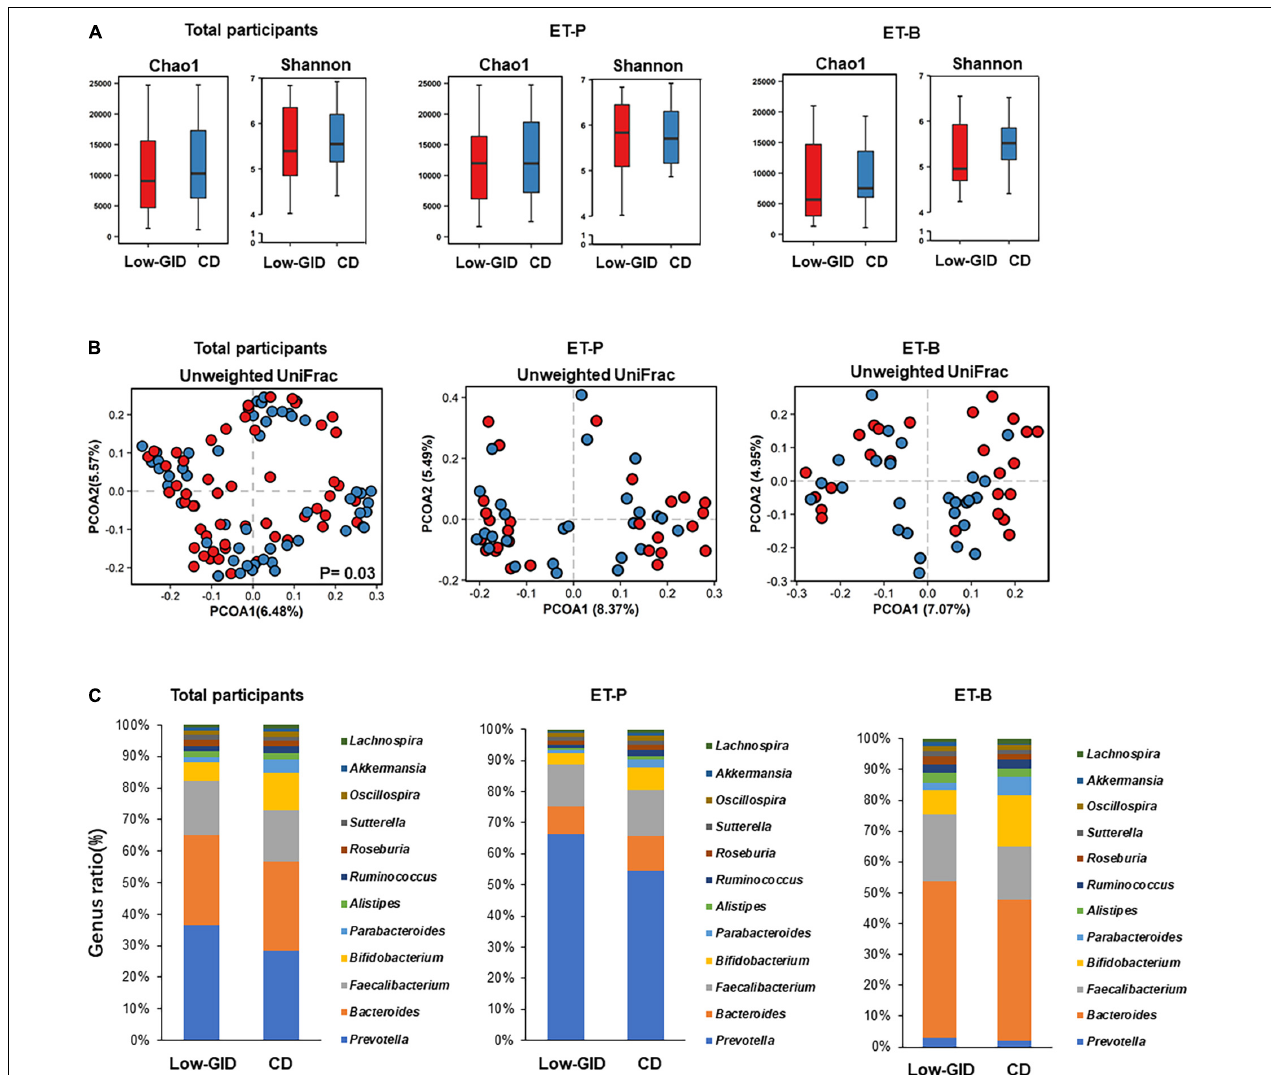
FIGURE 2 | The overall difference of intestinal microbes in the Prevotella and Bacteroides intestinal clusters after the Korean traditional balanced diet (Low-GID) and the westernized Korean diet, the control diet (CD), interventions. (A) The α -diversity difference between Chao and Shannon indices. (B) PCOA based on unweighted UniFrac. (C) Differences in the relative abundance of intestinal microbes at the genus level. Gut microbes with a total count of less than 400 and unclassified ones were truncated. A linear mixed model for α -diversity was used for statistical analysis; a significant difference is represented by p < 0.05. Using AMOVA for α -diversity’s statistical analysis, there is a significant difference when p <